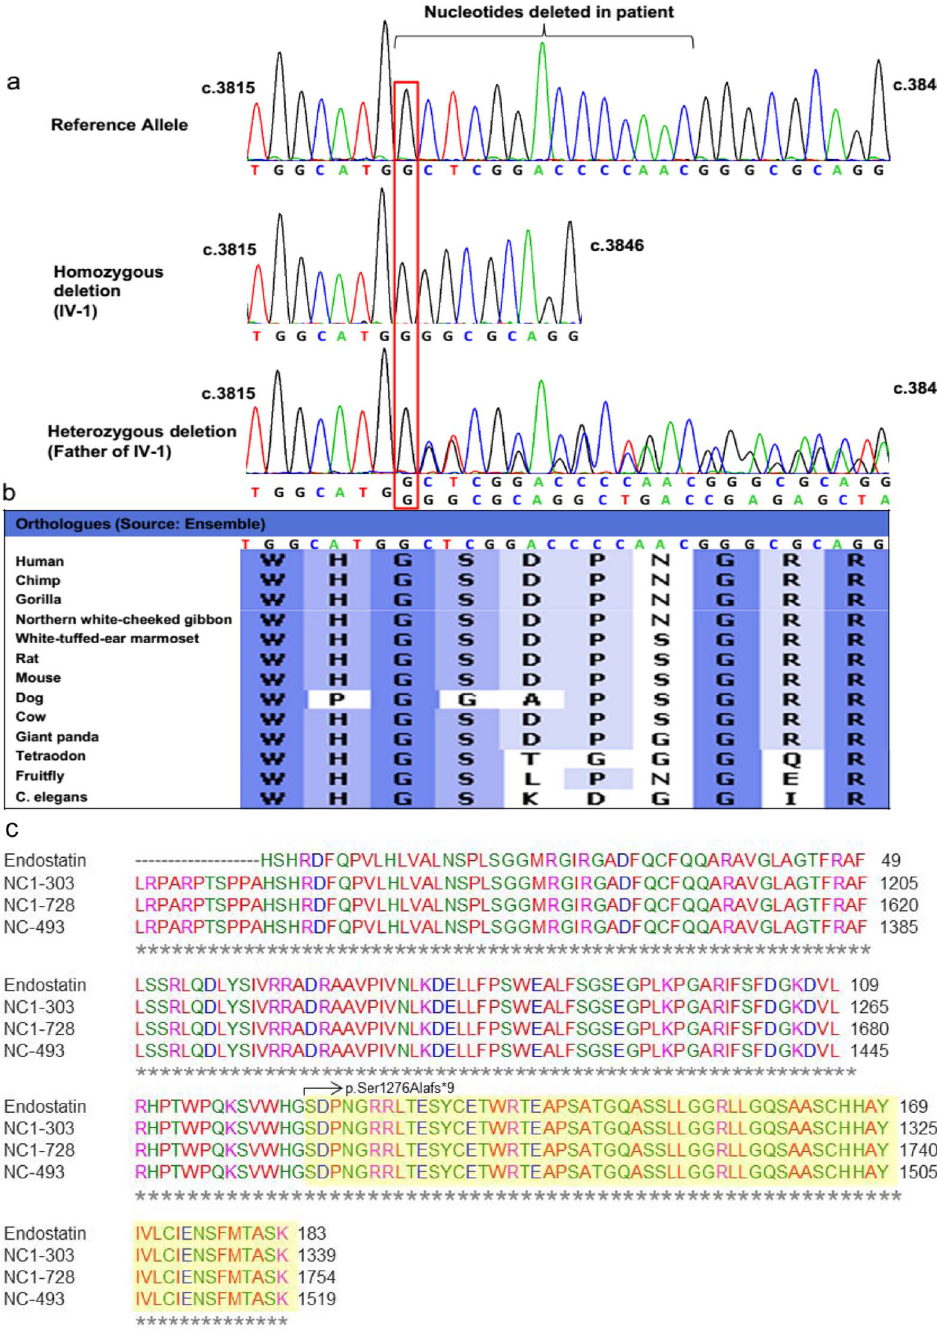
Figure 3. a. Sanger sequencing of COL18A1 mutation NM_130445.2:c.3825_3838del:p.Ser1276Alafs*9 (Exon 42) comparing a wild type sequence (top), homozygous deletion in index patient IV-1 (middle) and heterozygous deletion in father of the index patient (bottom). b. Conservation of the deleted nucleotides across various species. c. Alignment of three isoforms of COL18A1 and endostatin. The highlighted region is deleted in patient IV- 1.